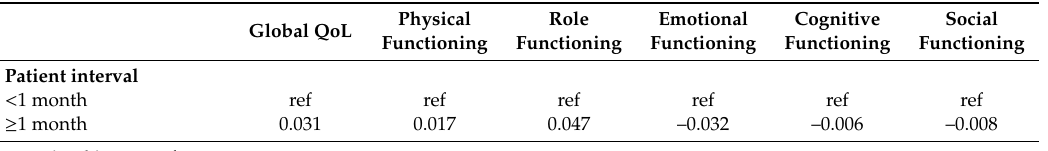
Table 2. Standardized betas of multivariable linear regression analysis evaluating the association of the patient interval and other variables with EORTC QLQ-C30